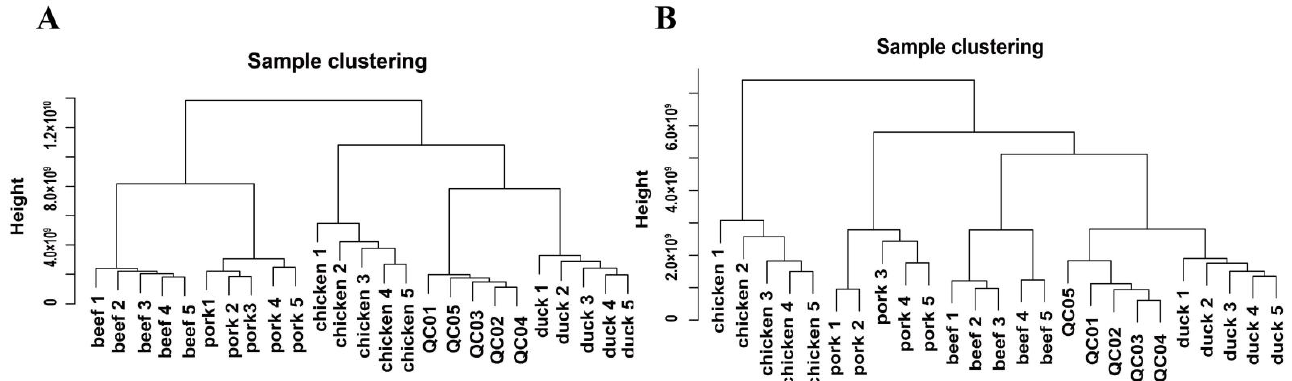
Figure 2. Hierarchical clustering analysis of metabolism of four livestock species. ( A ) Hierarchical clustering analysis of chicken, duck, pork, and beef in the positive ion mode. ( B ) Hierarchical clustering analysis of chicken, duck, pork, and beef in the negative ion mode.